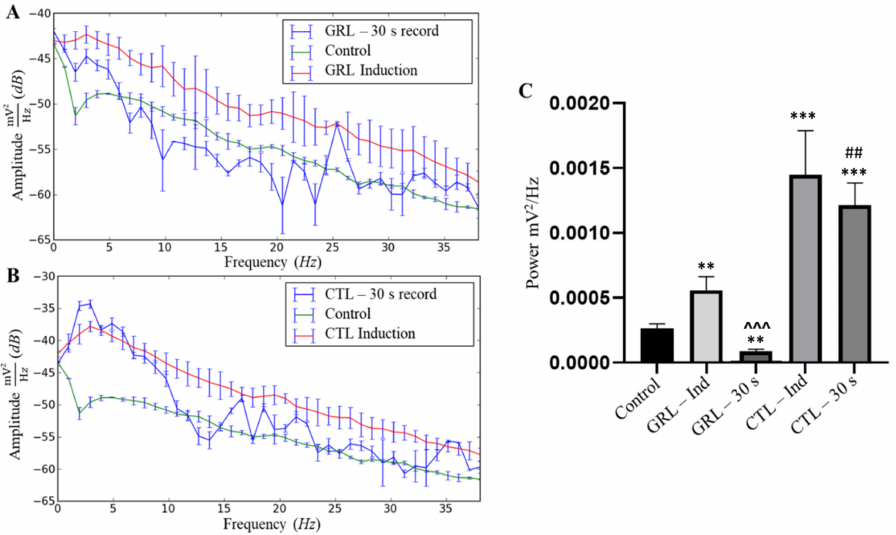
Figure 5. Power spectral density (PSD) of frequencies up to 40 Hz in tambaqui C. macropomum with comparisons among the last 30 s of the recordings (30 s), the control, total time of induction with geraniol (GRL—70 µ L · L − 1 ) ( A ), and total time of induction with citronellol (CTL—90 µ L · L − 1 ) ( B ). Differences in mean power among the control, ethanol, geraniol induction (GRL—Ind), citronellol induction (CTL—Ind), geraniol recovery (GRL—Rec), and citronellol recovery (CTL—Rec) groups are presented ( C ). * indicates statistical difference from the control group; ˆ indicates statistical difference from GRL—Ind group; # indicates statistical difference from the CTL—Ind group (after ANOVA followed by Tukey’s test). Symbols in duplicate **, ## correspond to p < 0.001; Symbols in triplicate indicate ***, ˆˆˆ correspond to p < 0.0001, ( n =